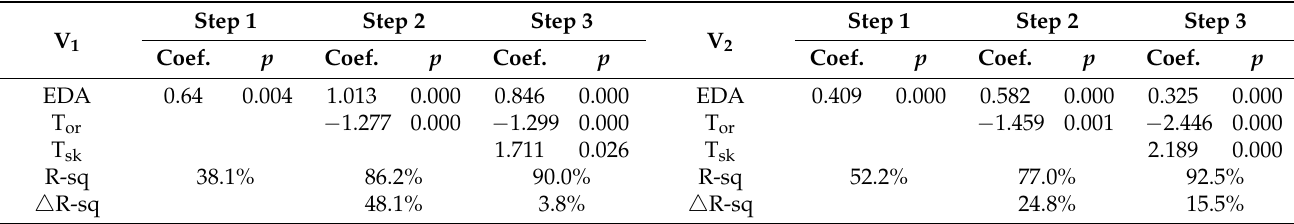
Table 3. Stepwise analysis of objective indicators and thermal sensation (TSV).